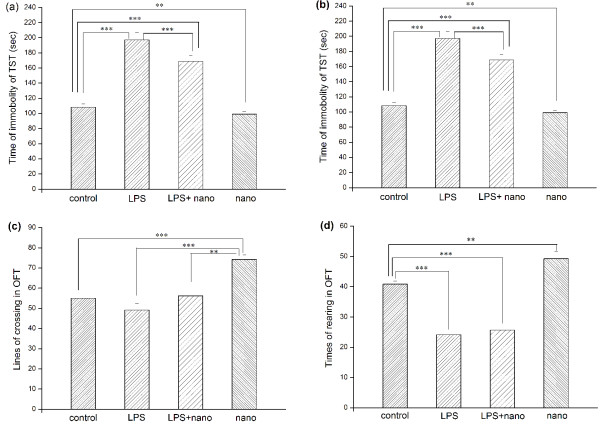
Performances in behavioral assays. Behavioral tests including forced swim test (FST), tail suspension test (TST) and open field test (OFT). Time of immobility was evaluated in the FST and TST as showed in A and B separately. Numbers of crossings and rearings were counted in the OFT as showed in C and D. Each data represents mean ± SEM. *P < 0.05, ** P < 0.01, ***P < 0.001.